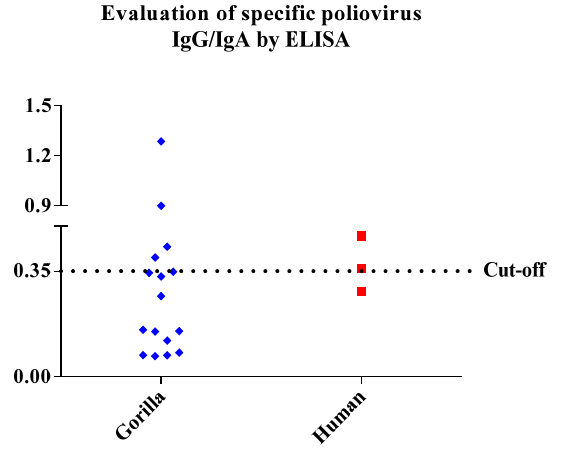
Figure 5. Evaluation of poliovirus IgG/IgA by ELISA. Graph representing the specific IgG/IgA (OD) level of all samples, measured at a wavelength of 450 nm. A sample was considered positive for IgG/IgA when the OD value was higher than or equal to the OD value of the cut-off control samples.